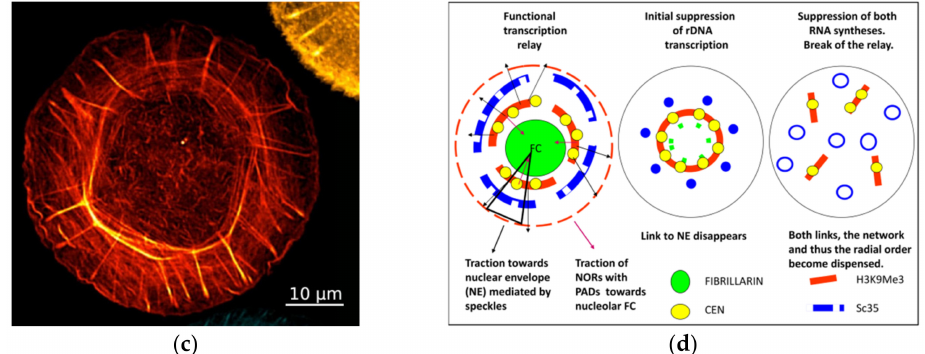
Figure 8. The speckles acting as radial spring pumps anchored between the nucleolar and perinuclear flexibly rigid heterochromatin shells and equipped by elastic actomyosin elements integrate the radial-concentric nuclear order for transcription pulsing. ( a , b ) EM thin sections of rat ascitic Zajdela hepatoma cells: ( a ) The links of the speckle (ICG) to the perinucleolar and perinuclear heterochromatin (arrows), Nl—nucleolus; ( b ) the view of the radial-concentric speckle substructure as revealed on shortly cold-PF-prefixed cells after short DNAse I treatment with 4.5 mM MgCl 2 in phosphate buffer/sucrose before dehydration and epoxy-embedment (conventional contrasting). ICG—speckle, HR—heterochromatin, Nl—nucleolus. Republished from [53]. ( c ) The representative image of the circular-radial self-organization of F-actin filaments (stained by phalloidin) of human foreskin fibroblasts, structured soon after seeding on isotropic substrate; from [108]. ( d ) Schematic of the functional transcriptional relay in its relationship with speckles and the concentric rings of the nucleolar and perinuclear heterochromatin shells, deduced from experiments with suppression of RNA synthesis and the literature on the participation of the nuclear cytoskeleton in it. Modified from